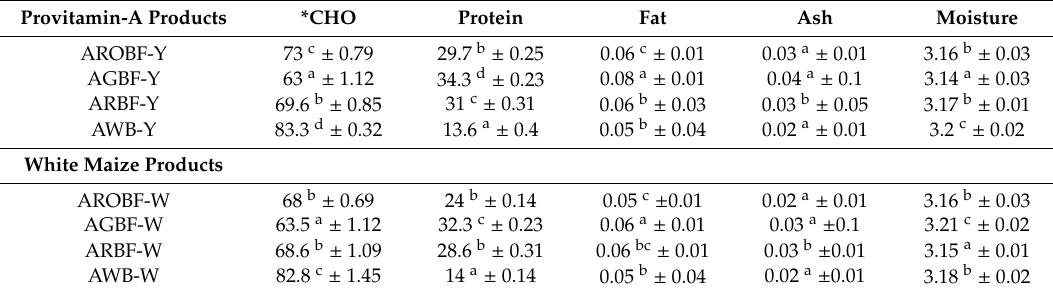
Table 2. Proximate composition of amahewu samples (g / 100 g, db).